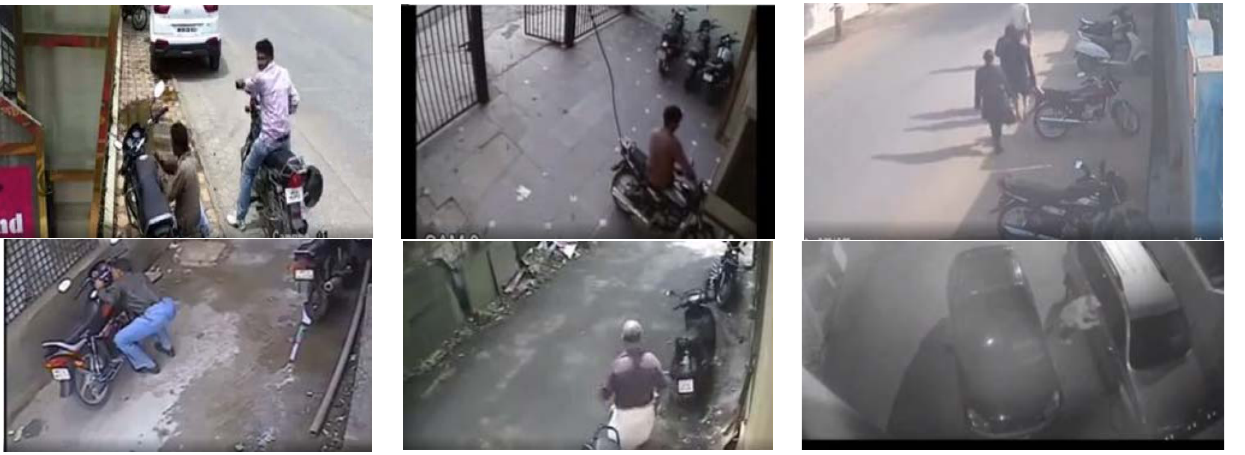
Figure 6. Identification of stealing action from the dataset with different places and different objects.